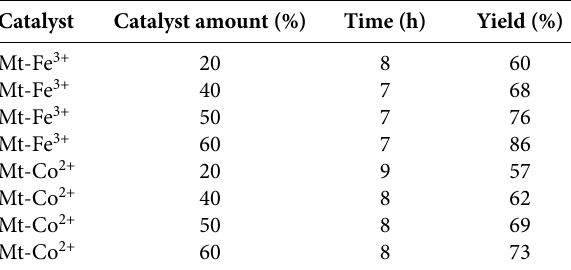
Table 4. Effect of the catalyst amount on the yield of the reaction.